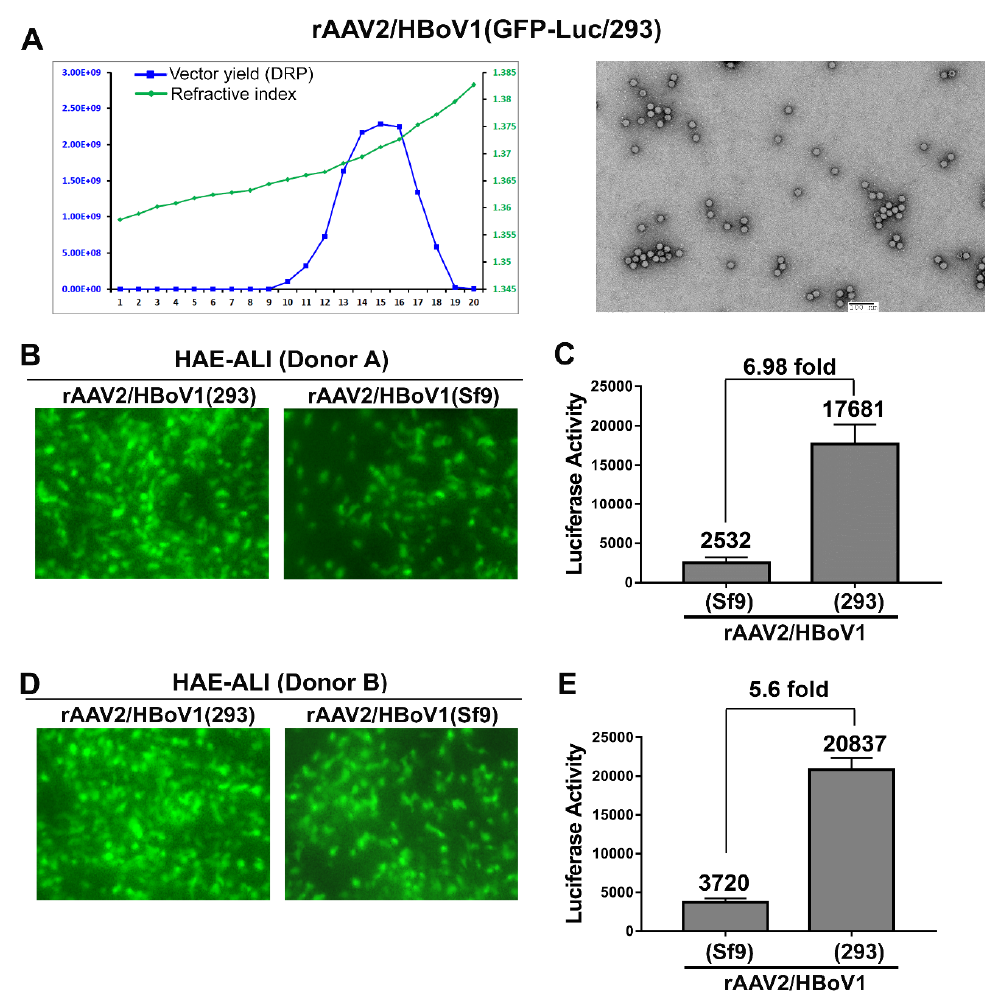
Figure 4. Comparison of the transduction efficiency between the rAAV2/HBoV1 vectors produced in Sf9 cells and HEK293 cells. ( A ) rAAV2/HBoV1 vector produced from HEK293 cells. HEK293 cells were transfected with pAAV2ITR-GFP-Luc, pCMVNS*Cap-P5Rep, and pHelper. Cell lysates from infected cells were fractionated by CsCl equilibrium ultracentrifugation. Left panel: qPCR analysis was used to determine the DRP in each fraction (blue line); the density of each fraction was determined as refractive index using an Abbe refractometer and is shown by the line in green. Right panel: a transmission electron micrograph of rAAV2/HBoV1(293) vectors. ( B – E ) rAAV2/HBoV1 transduction